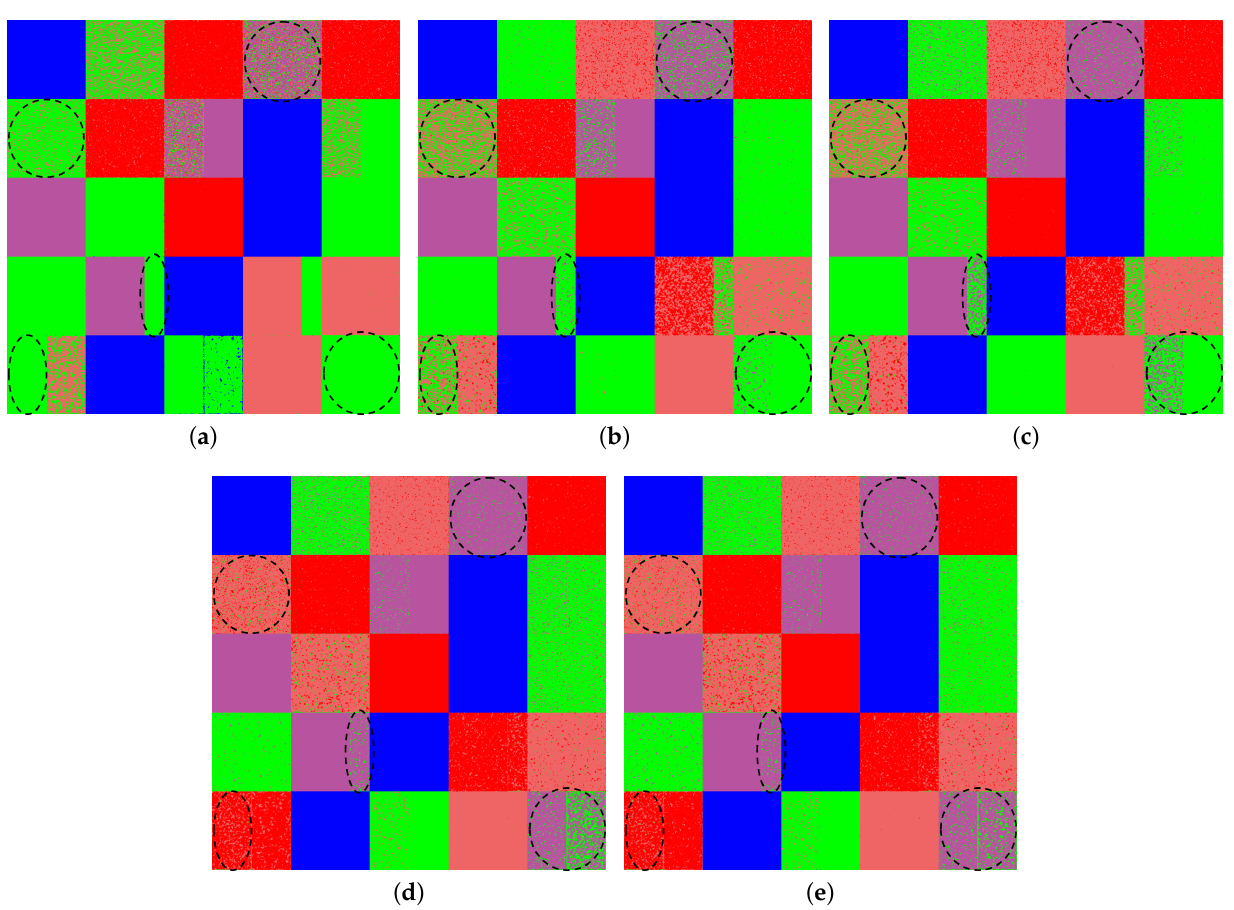
Figure 4. The ML-based classification maps of five models on the simulated PolSAR dataset.